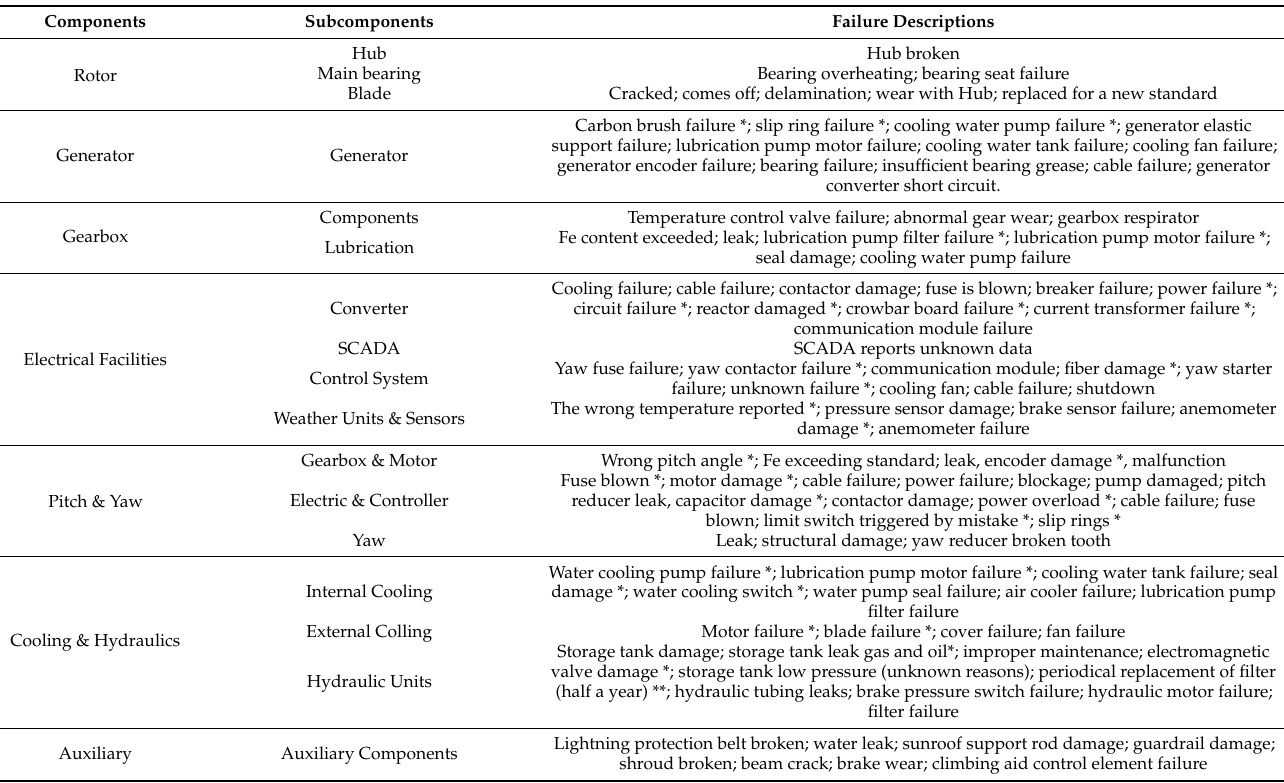
Table A1. Failure modes of main components.